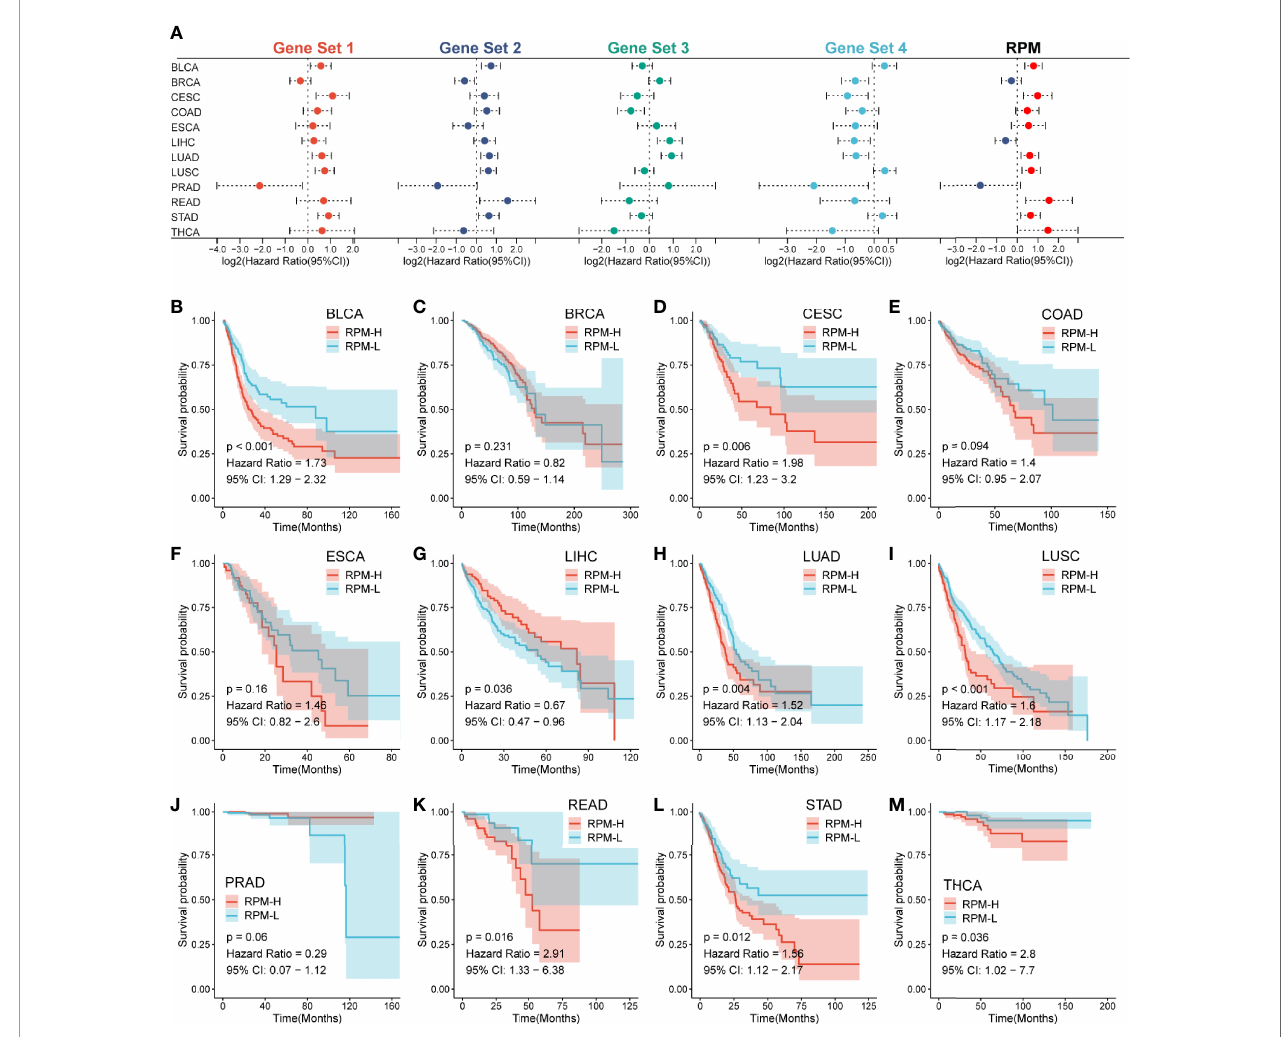
FIGURE 6 | RPM predicts prognosis across multiple cancer types. (A) A forest plot showed the HR of Gene Sets 1 – 4 and RPM across 12 types of cancers. (B – M) Kaplan – Meier analysis showed differences in survival between RPM-L and RPM-H across 12 types of cancers; RPM, risk prediction model; HR, hazard